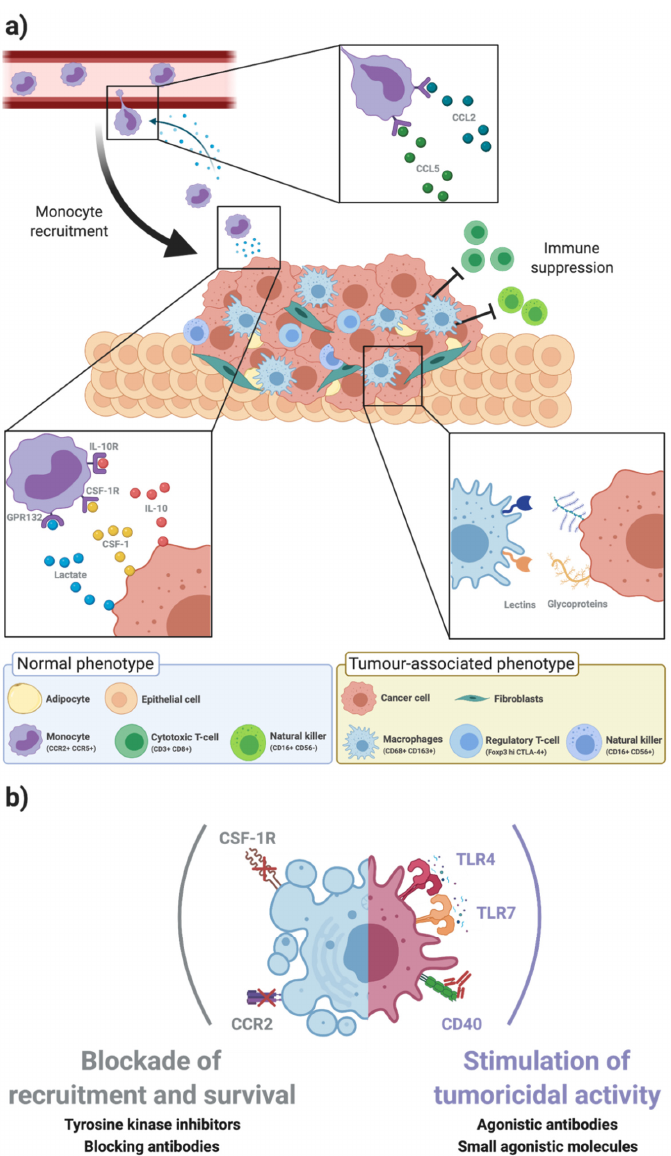
Figure 1. Tumour-associated macrophages modulate the breast cancer microenvironment. ( a ) The breast cancer (BC) microenvironment is composed by stromal cells (as fibroblasts, adipocytes, endothelial cells) and the immune infiltrate. Immune cells, such as T lymphocytes, natural killer (NK) cells and monocytes, are recruited to the tumour site at early stages. Monocytes are recruited from the bloodstream by chemokines secreted by the tumour cells, such as C-C motif chemokine ligand 2 (CCL2) and CCL5 (top inset). Within the BC microenvironment, monocytes polarize into immunosuppressive tumour associated macrophages (TAM), in a process regulated by cytokines, growth factors, and other signals secreted by tumour and stromal cells, such as interleukin 10 (IL-10), colony stimulating factor 1 (CSF-1), and lactate, recognized by the IL-10 receptor (IL-10R), the CSF-1 receptor (CSF1R), and G protein-coupled receptor 132 (Gpr123) (bottom left inset). The recognition of highly glycosylated proteins on tumour cells, such as mucin 1 (MUC1) and cluster of differentiation 24 (CD24), by immune glycan-binding receptors (lectins) also contribute to polarization into immunosuppressive TAM phenotypes (bottom right inset). TAM represent a high fraction of the microenvironment of human epidermal growth factor receptor 2 (HER2) overexpressing BC and triple negative BC (TNBC), being implicated in the modulation of stromal cells into a protumour phenotype and suppression of other immune cells, such as regulatory T cells and NK cells. ( b ) Macrophages as targets for novel immunotherapies. Due to the relevance of TAM in promoting an immunosuppressive BC microenvironment, they have been proposed as therapeutic targets for immunotherapy. Strategies that have reached clinicals trials include (i) blockade of the axes responsible for macrophage recruitment and survival, such as CCL2 and CSF-1 and (ii) stimulation of TAM tumoricidal activity, by triggering the TLR4, TLR7 or CD40-mediated pathways